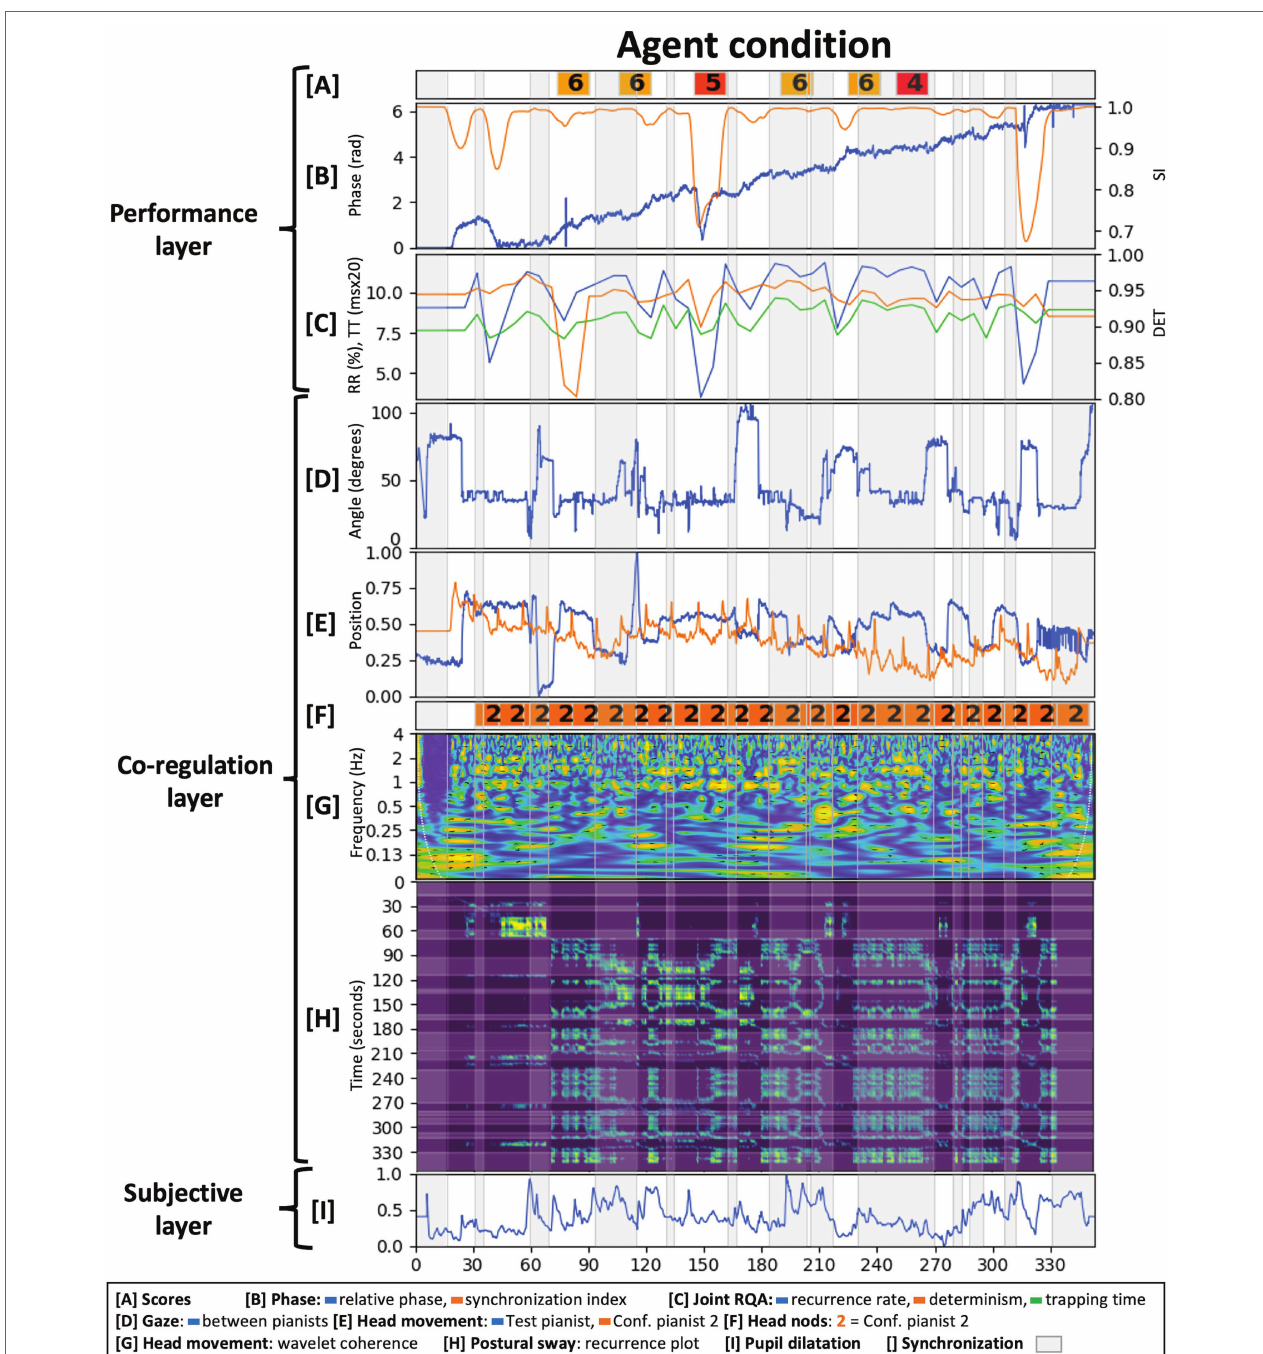
FIGURE 8 | Analysis of the agent condition across the three interrelated layers from the proposed methodological